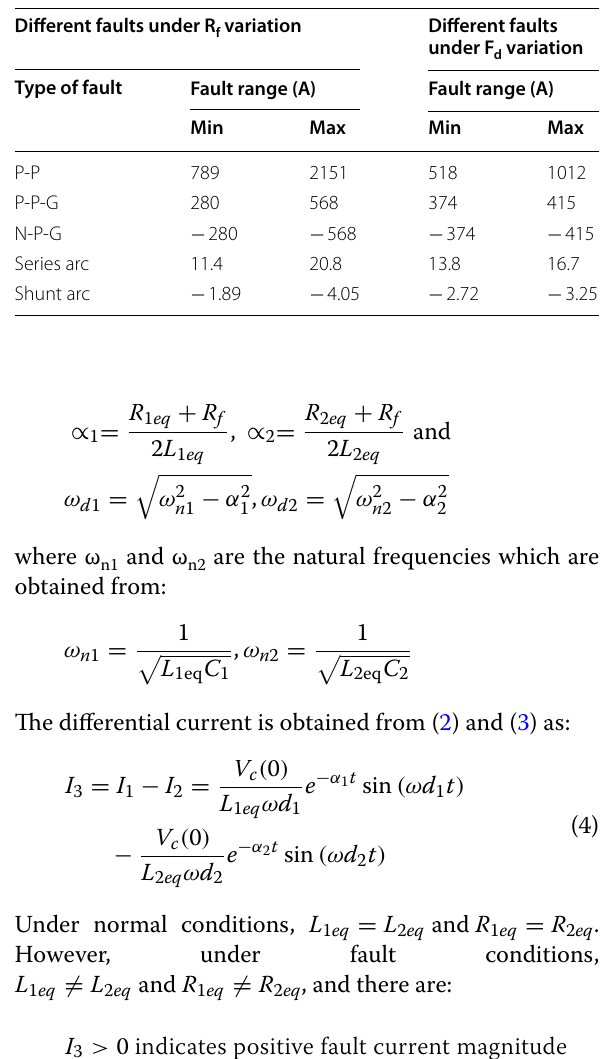
I 3 > 0 indicates positive fault current magnitude I 3 < 0 indicates negative fault current magnitude. Based on the above conditions, different faults in various case studies under fault resistance variation and fault distance variation in the faulty cable are identified with the maximum and minimum peak amplitudes of